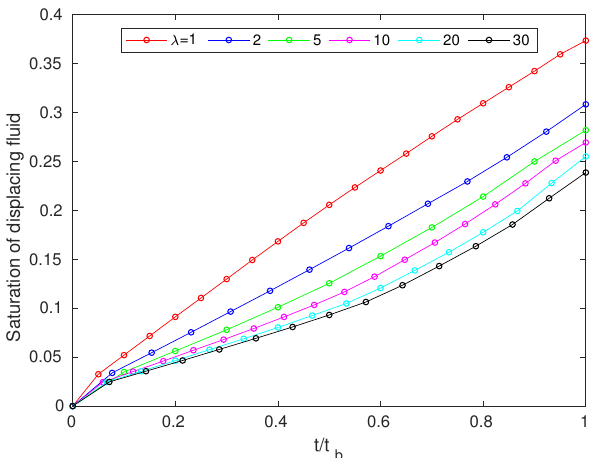
Figure 5. Evolution of the displacing fluid saturation for the viscosity ratio λ increased from 1 to 30 at σ = 0.015 mu · ts − 2 and θ = 120 ◦ (imbibition). Note that the time is normalized by t b , defined as the time at which the breakthrough occurs.